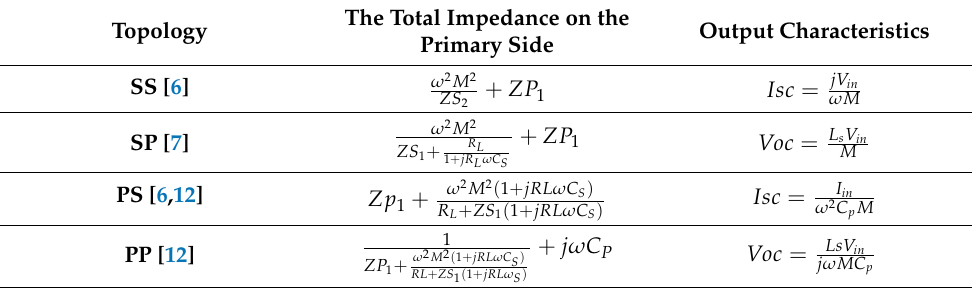
The Total Impedance on the Output Characteristics Primary Side + ZP 1 ZS 2